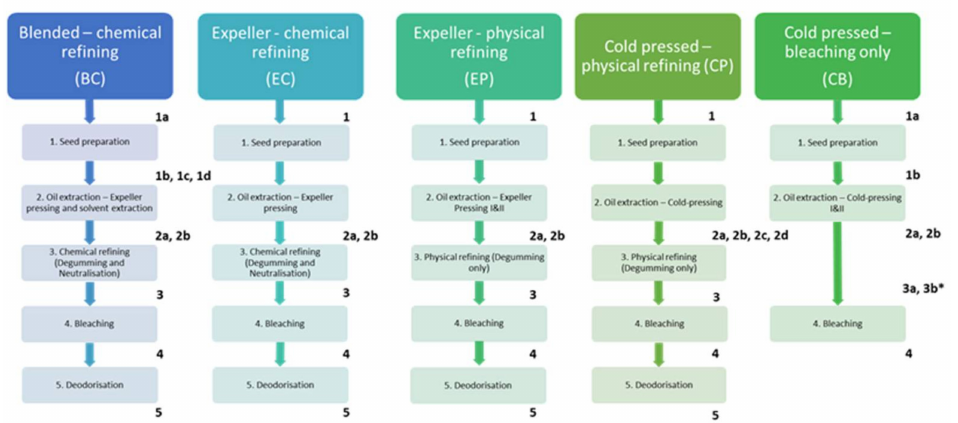
Figure 1. Process flow diagram and description of stages sampled within each process. Sampling points are indicated by numbers in bold typeface. 1 = seed, 2 = crude oil, 3 = degummed and neutralized oil, 4 = bleached oil, 5 = deodorised oil. Letters (i.e., 2a, 2b) differentiate multiple seed/oil samples taken at a sampling stage. 3a, and 3b* are samples obtained from a second press oil for process CB and this process is discussed independently in Section